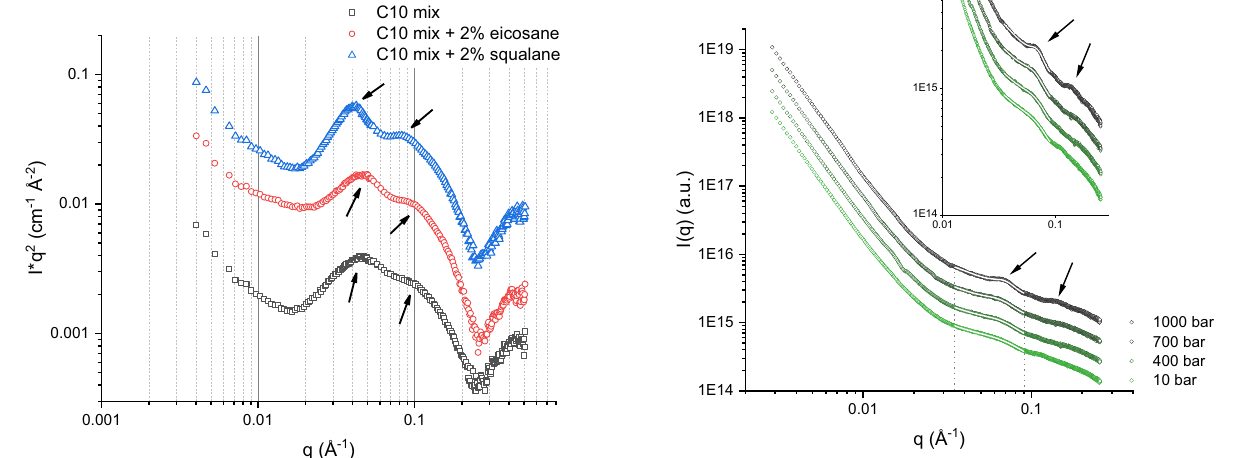
Fig. 6 Sample lamellarity at ambient temperature. SANS curves obtained for the three samples at 80 mM concentration and T = 21 °C. The arrows indicate the position of the fi rst two orders of the MLV correlation for the three samples. The curves of eicosane- and squalane-enriched samples were shifted vertically for clarity.